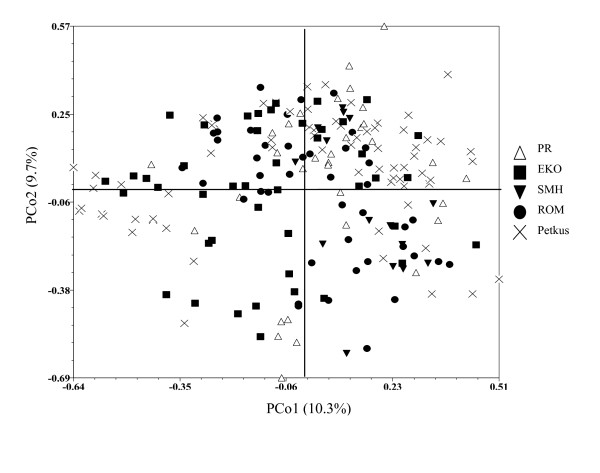
Principal co-ordinate analysis of 201 rye lines from five populations (PR, EKO, SMH, ROM, Petkus) based on candidate gene haplotypes. Analysis was based on a similarity matrix of candidate gene haplotypes. PCo1 and PCo2 are the first and second principal co-ordinates and percentages indicate percent variation explained.